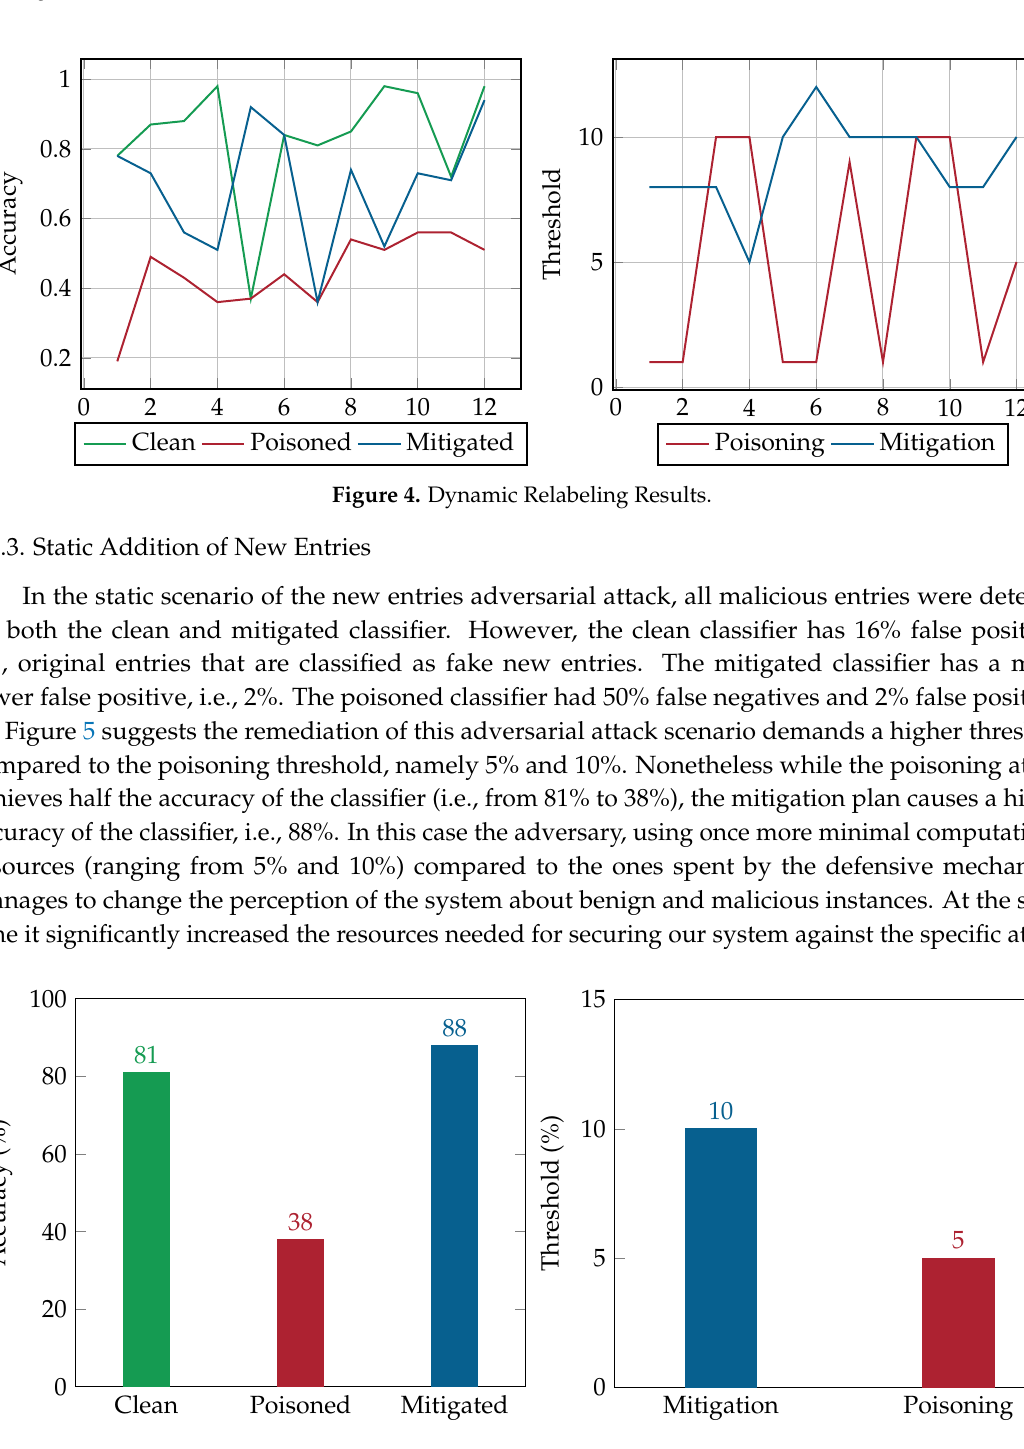
Figure 5. Static New Entries